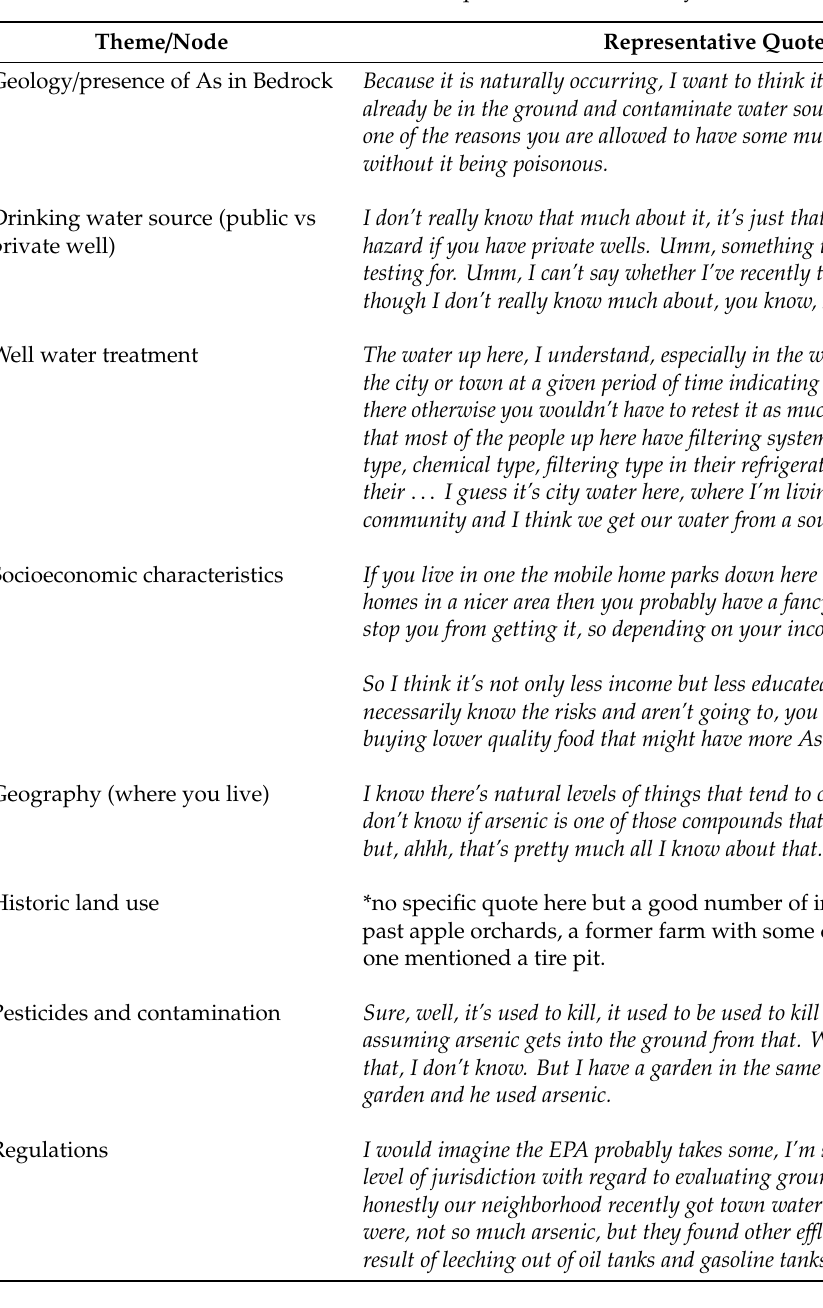
Table 2. Themes and quotes from community